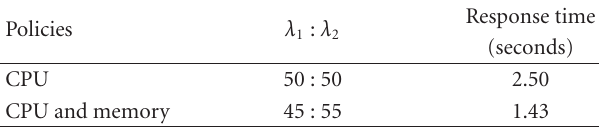
Table 2: Results of the queuing